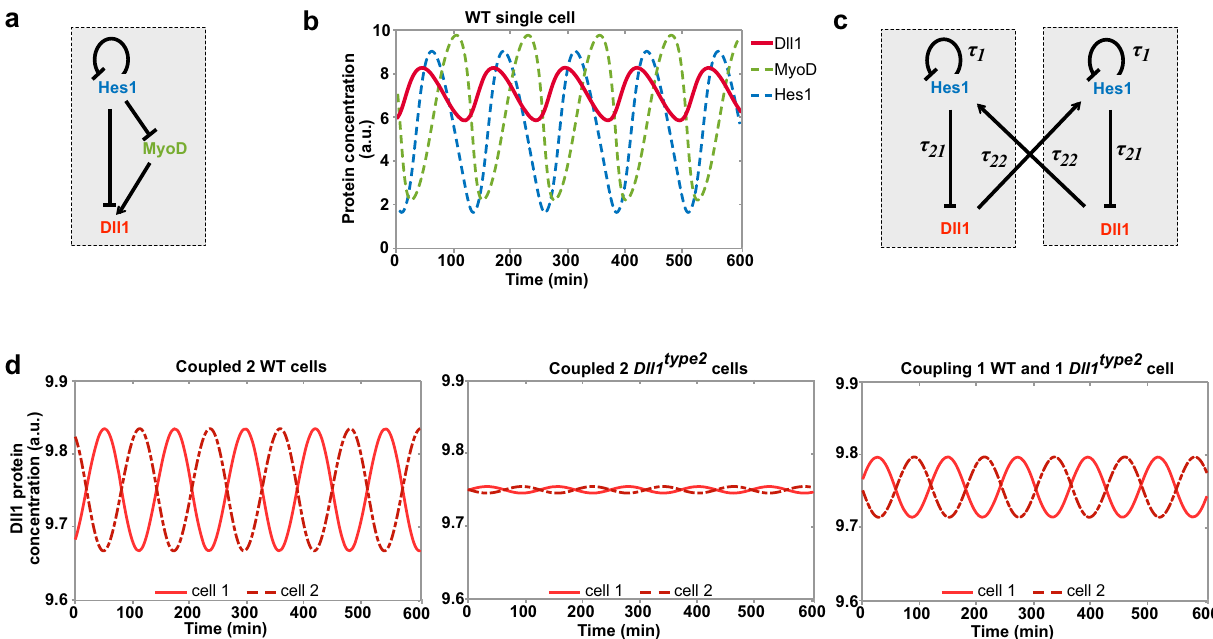
Fig. 5 Mathematical modeling of the dynamic Dll1 expression in single and coupled wild-type and Dll1 type2 mutant muscle stem cells. a Scheme of the transcriptional regulation of Dll1 by Hes1 and MyoD. b Prediction of the expression dynamics of Dll1, MyoD, and Hes1 proteins using a single-cell ordinary differential equation model. c Scheme of the Dll1 and Hes1 regulatory mechanisms in two coupled cells underlying the coupled-cell delay differential equation model. In each cell, Hes1 represses its own as well as Dll1 transcription in a cell-autonomous manner; in addition, Dll1 in one cell induces Hes1 in the neighboring cell. d Simulation of the dynamic expression of Dll1 in two coupled wild-type (WT) cells (left), two coupled Dll1 type2 mutant cells (middle), and a chimeric situation in which one cell is Dll1 type2 mutant and the other is wild-type (WT). See Methods and Supplementary Methods for detailed information about the derivation and parametrization of the mathematical